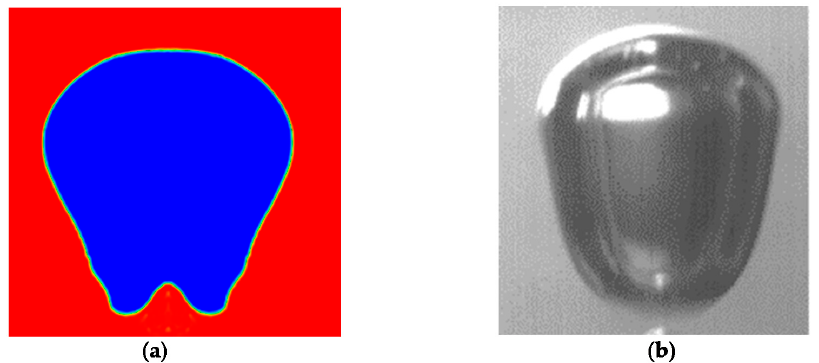
Figure 10. Frame of bubble 1 ms after the detachment: ( a ) Computational Fluid Dynamics (CFD), ( b ) Experiment G2 (Q = 1.09 × 10 − 6 m 3 /s).